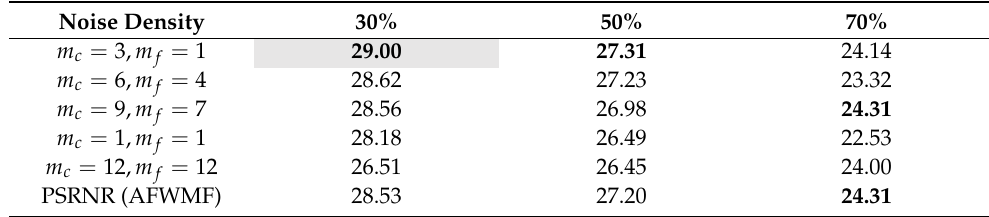
Table 13. The PSNR value for setting parameters by referring to the PSRNR formula (Gold Hill